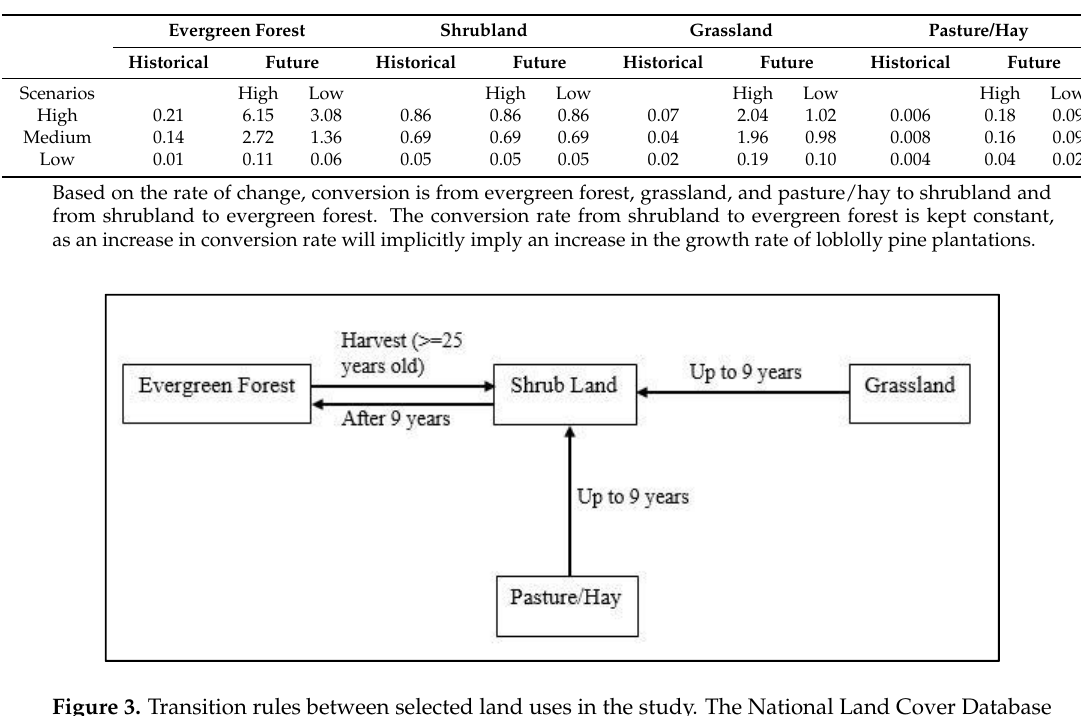
Figure 3. Transition rules between selected land uses in the study. The National Land Cover Database defines shrubland as areas dominated by shrubs that are less than five meters tall with shrub canopy typically >20% of total vegetation [28]. We have assumed that loblolly pine attains the height of five meters by the age nine.